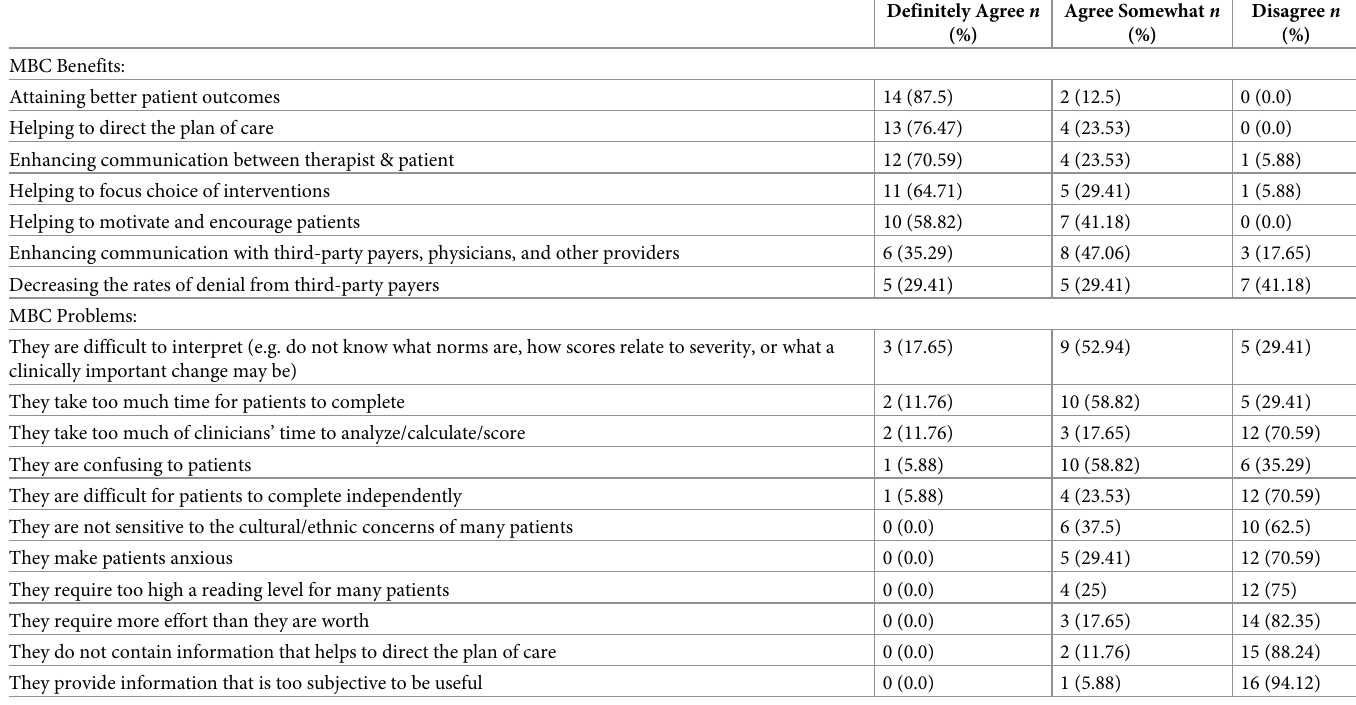
Table 2. STAR-Center clinician ratings of MBC benefits and challenges (n = 17